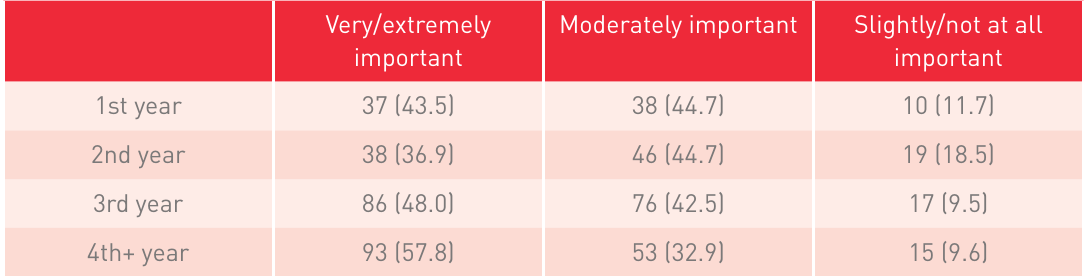
Table 1. Attitudes towards CE among university students in varying years of study (number (%) responding to the question ‘How important is CE to you?’) Very/extremely Moderately important Slightly/not at all important